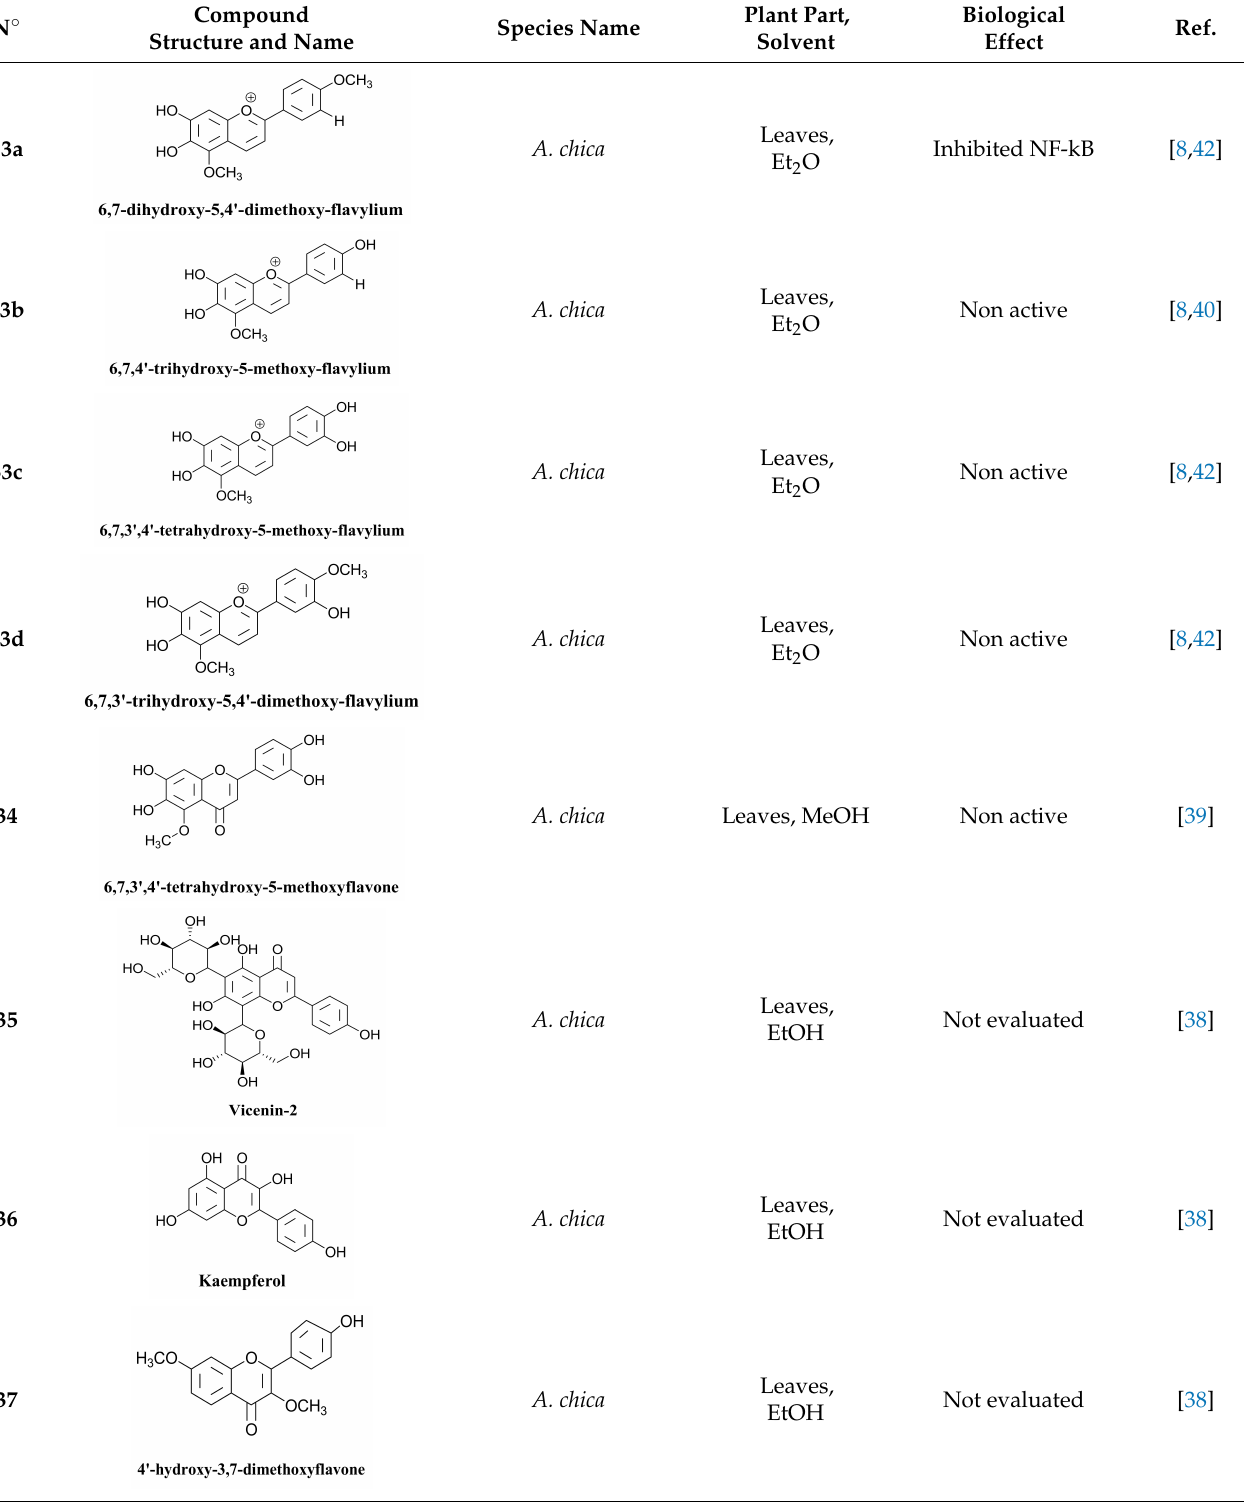
Table 6. Structure and bio-pharmacological properties of isolated compounds from A. chica